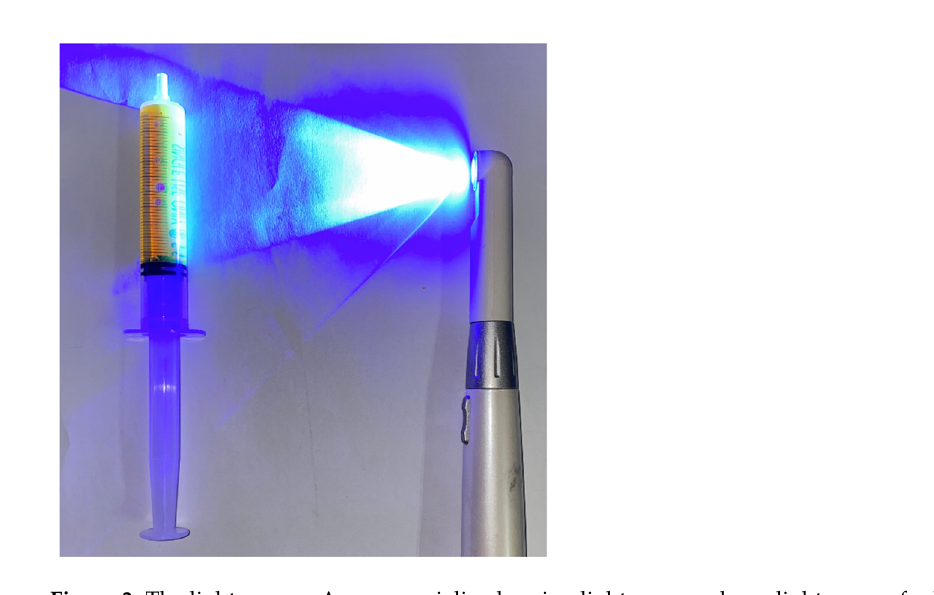
Figure 3. The light source. A commercialized curing light was used as a light source for blue light fluorescence.